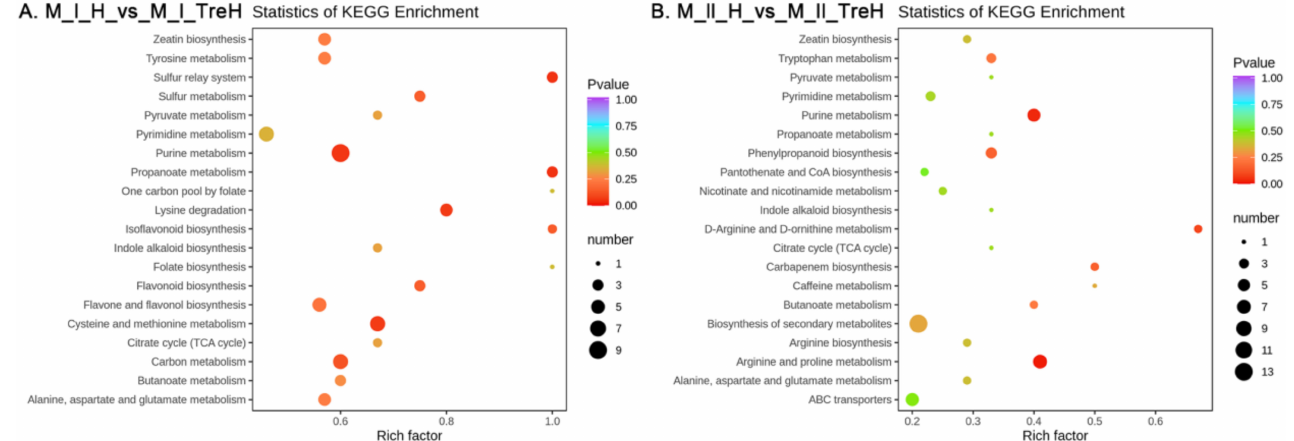
Figure 10. KEGG enrichment analysis of differential metabolites. M—the metabolomics; I—Yangmai 18; II—Yannong 19; H—heat stress treatment for 24 h; TreH—trehalose pretreatment for 3 d followed by high-temperature treatment for 24 h. The ordinate represents the KEGG pathway. The abscissa represents the rich factor. The larger the rich factor, the greater the enrichment